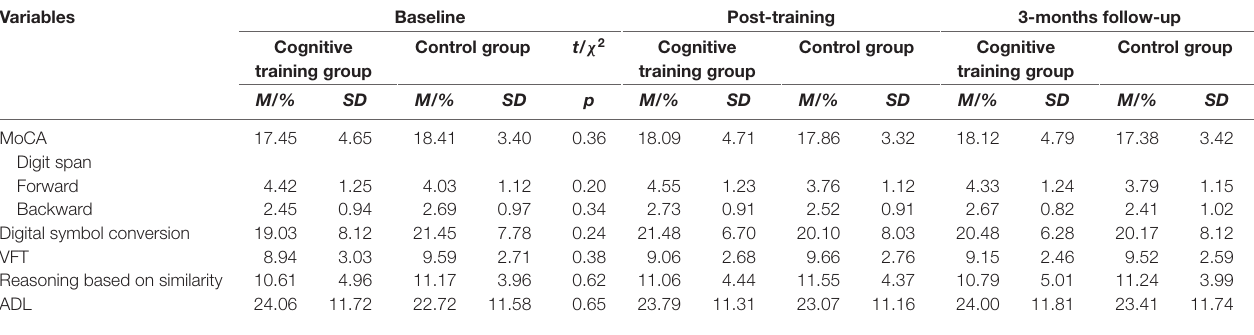
TABLE 2A | Three time-points (baseline, post-training and 3 months after training) data of cognitive training group and control group. Variables